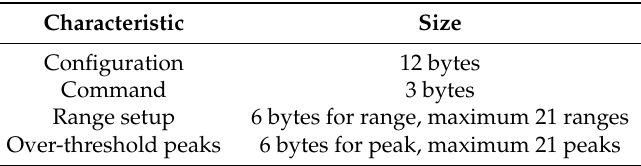
Table 2. Size of characteristics transferred via Bluetooth